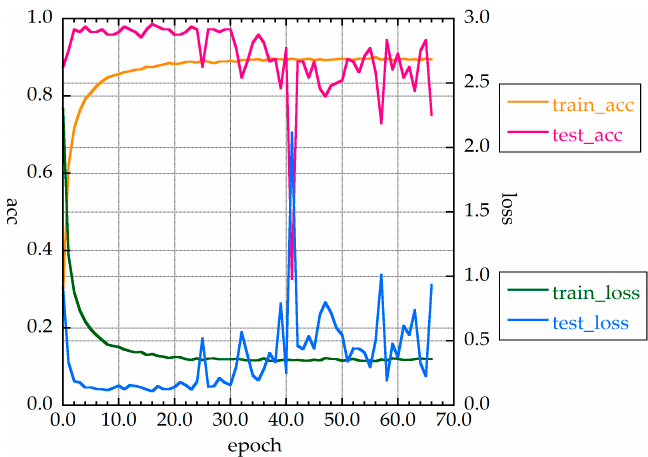
Figure 16. Accuracies and loss function values of CNN2d_HQ.